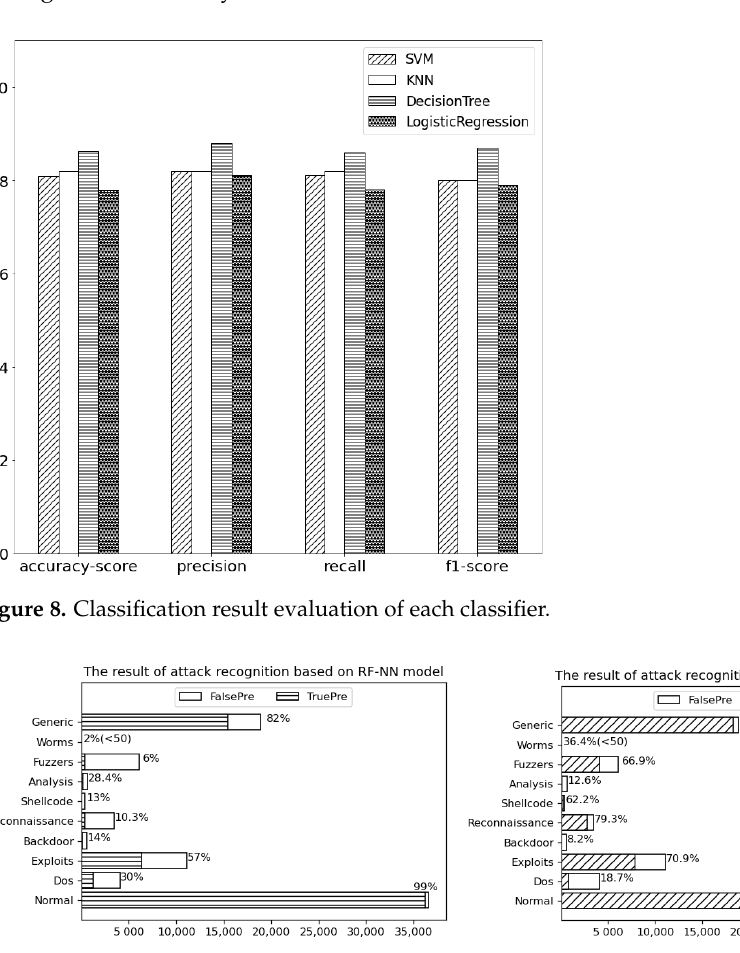
Figure 9. Accuracy of identifying various